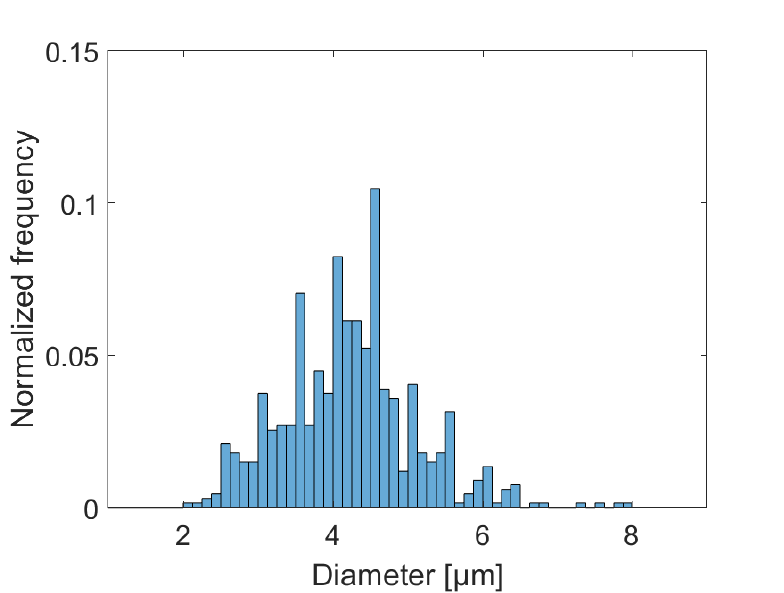
Figure 2. The number distribution of droplets obtained using optical microscopy at 20 × magnifica- tion. The mean diameter for these droplets was measured at 4.2 ± 0.9 µm.